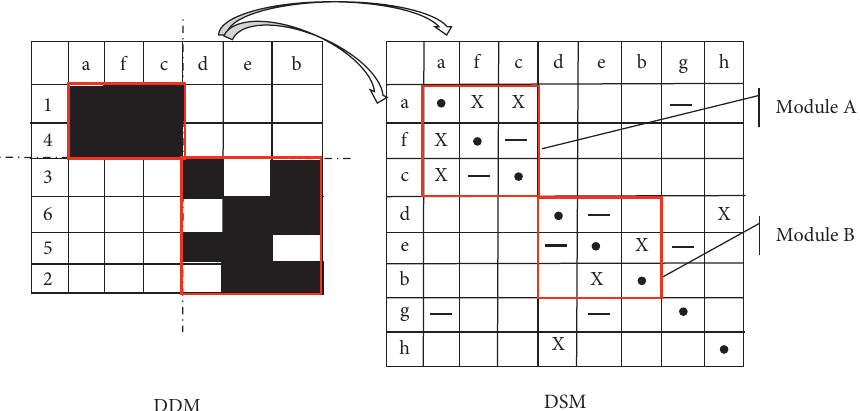
Figure 3: DSM prototype mapping to DDM.